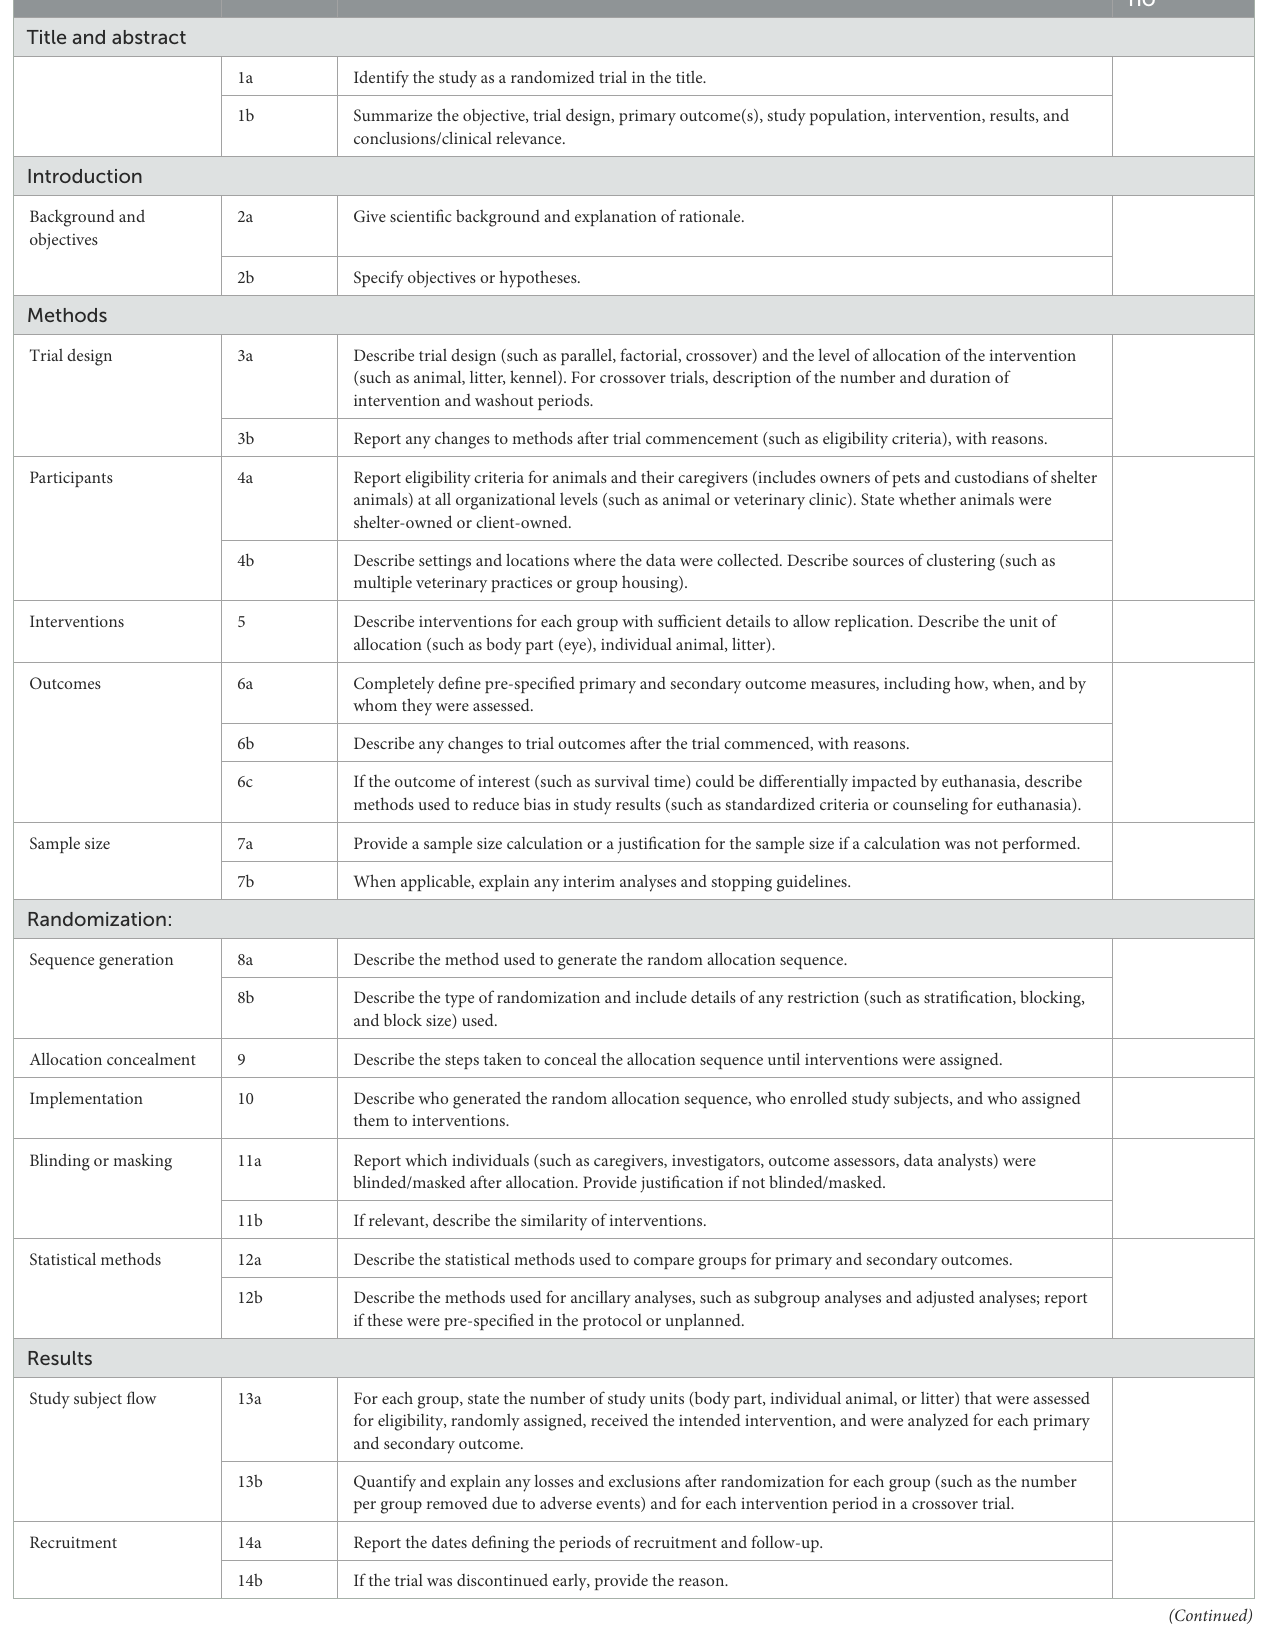
TABLE 1 PetSORT checklist of information to include when reporting a randomized trial.